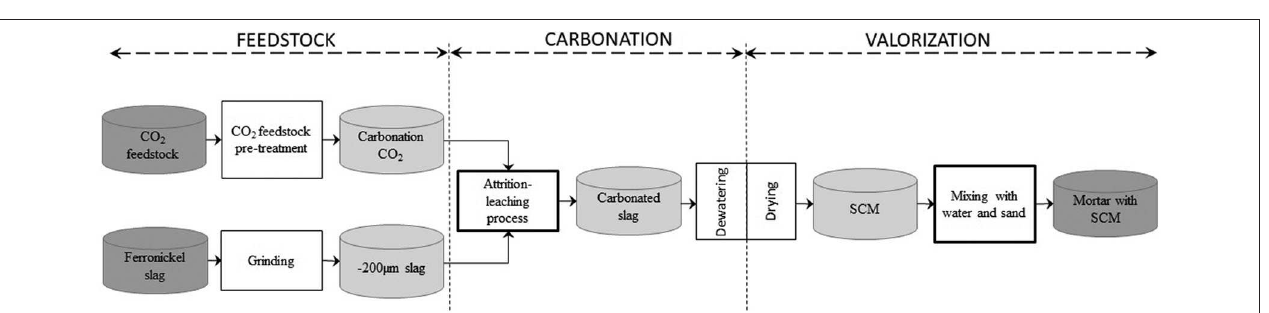
FIGURE 5 | ICM technological cycle template for the production of SCM from ferronickel